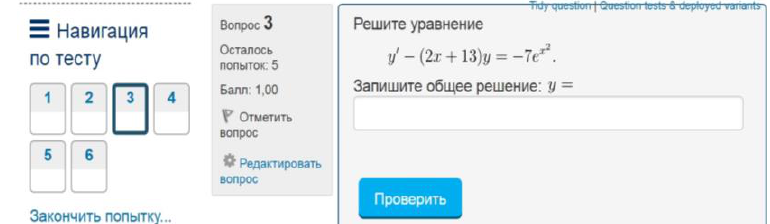
Fig. 5. STACK task on differential equation solution (TSU) / test navigation, finish attempt / question, attempts left, score, mark the question, edit question / Solve the equation. Enter the general solution.